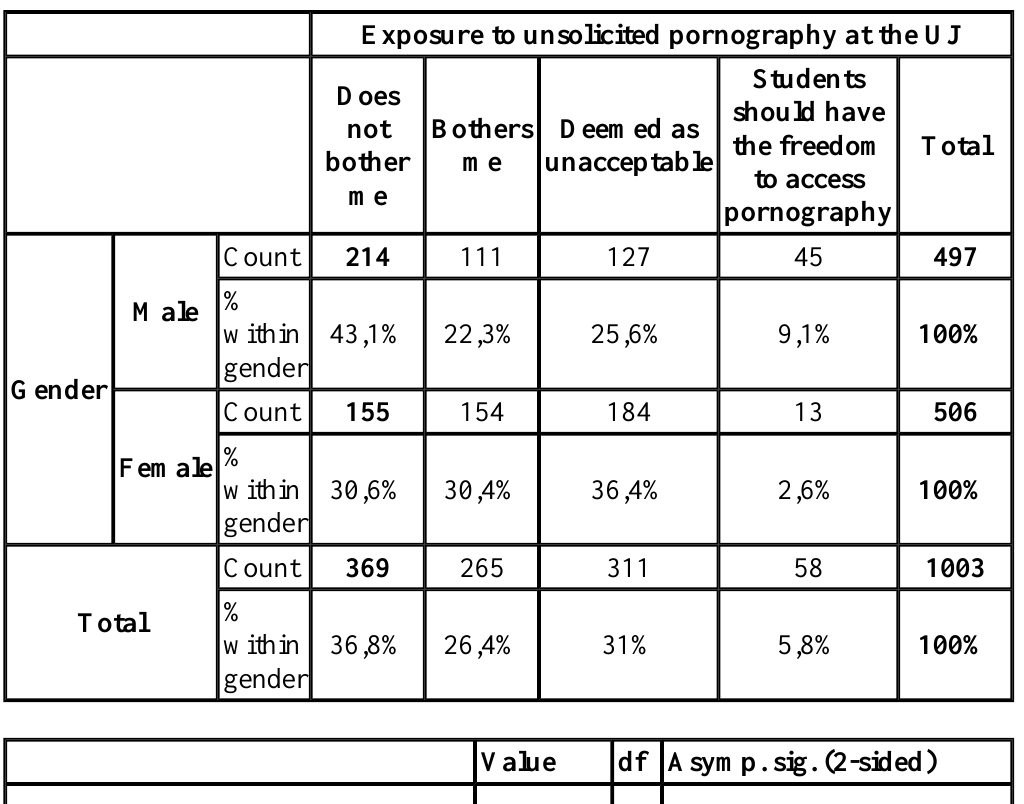
Table 4 Cross tabulation of gender differences for Question 12 (exposure to unsolicited pornography at the